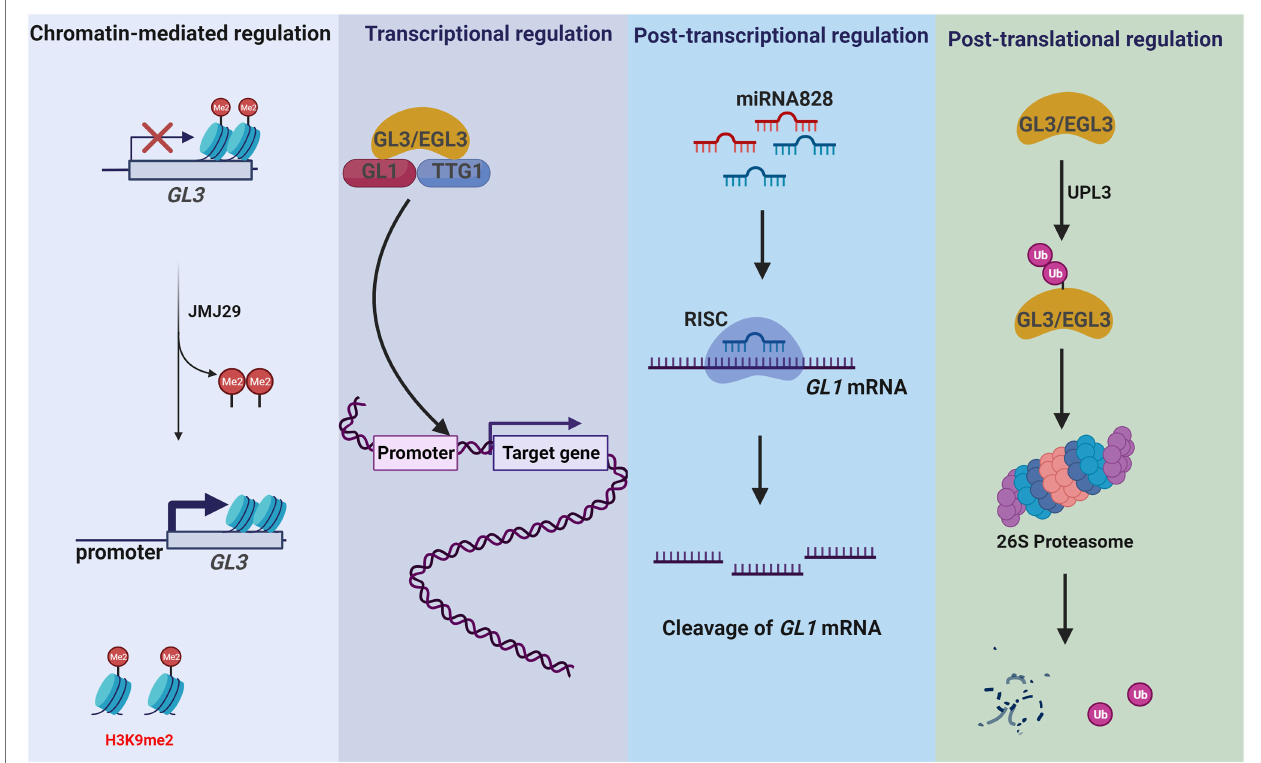
FIGURE 4 | GL3/EGL3 and GL1 are involved in multi-dimensional regulation of Arabidopsis trichrome development. GL3/EGL3 and GL1 are important regulators of Arabidopsis trichome development. They control trichome development by different regulation modes. JMJ29 directly demethylates H3K9 on the GL3 locus, thereby regulating GL3 expression in trichome initiation (chromatin-mediated regulation). As TFs, GL3/EGL3 and GL1 regulate the expression of trichome development- related genes (transcriptional regulation). In Arabidopsis , miR828 promotes the degradation of GL1 and inhibits trichome formation (post-transcriptional regulation). In addition, ubiquitination modification controls the level of GL3. UPL3 mediates the proteasome degradation of GL3/EGL3 and represses the formation of GL1- GL3/EGL3-TTG1 complex (post-translational